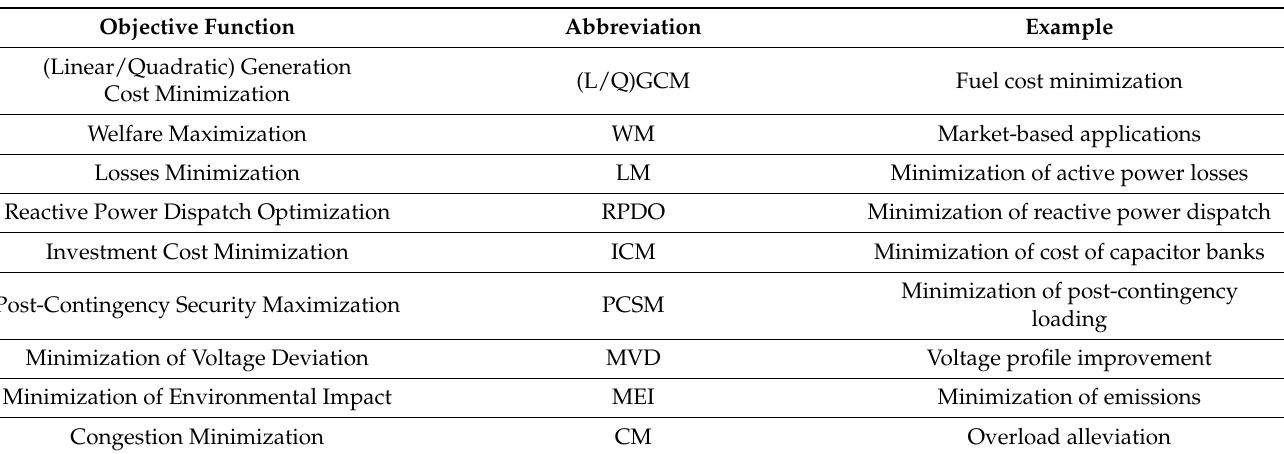
Table 2. Common OPF objective function